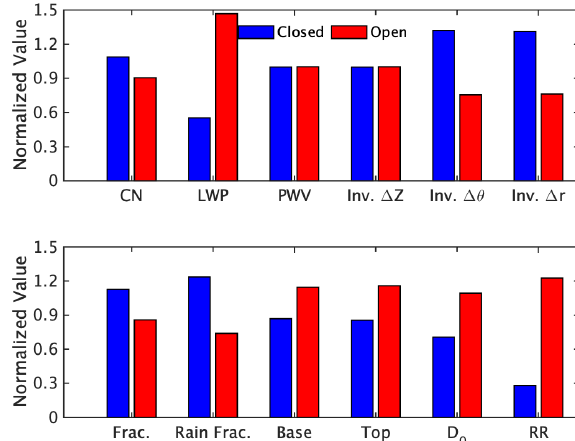
Figure 11. Normalized values of boundary layer and cloud proper- ties for closed-cellular (blue) and open-cellular (red)